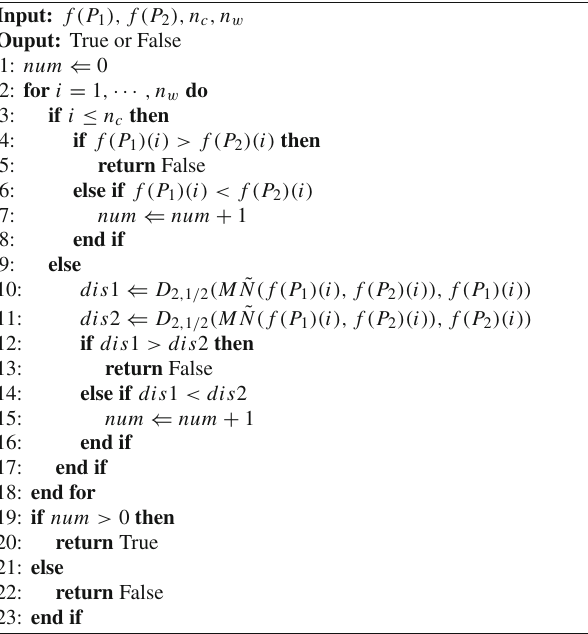
Algorithm 2 Determine whether P 1 ≺ P